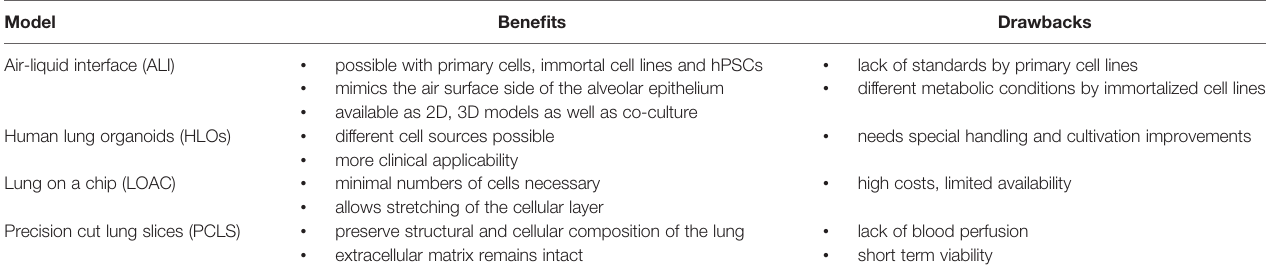
TABLE 2 | Bene fi ts and drawbacks of different in vitro lung models.